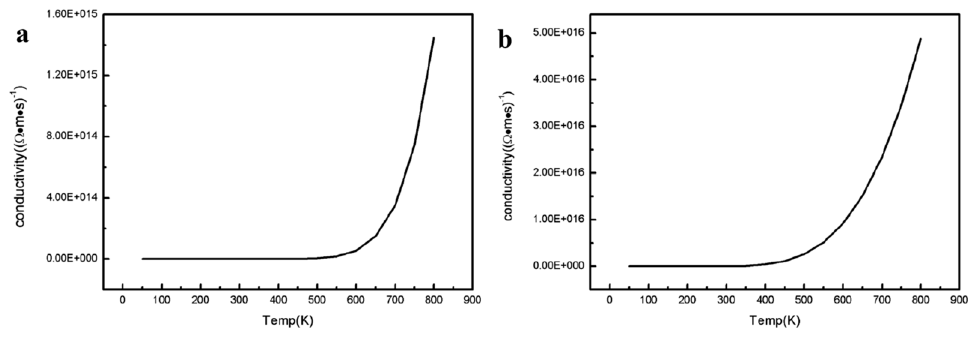
Figure 4. conductivity ( a ) AlN, ( b ) B 0.2 Al 0.8